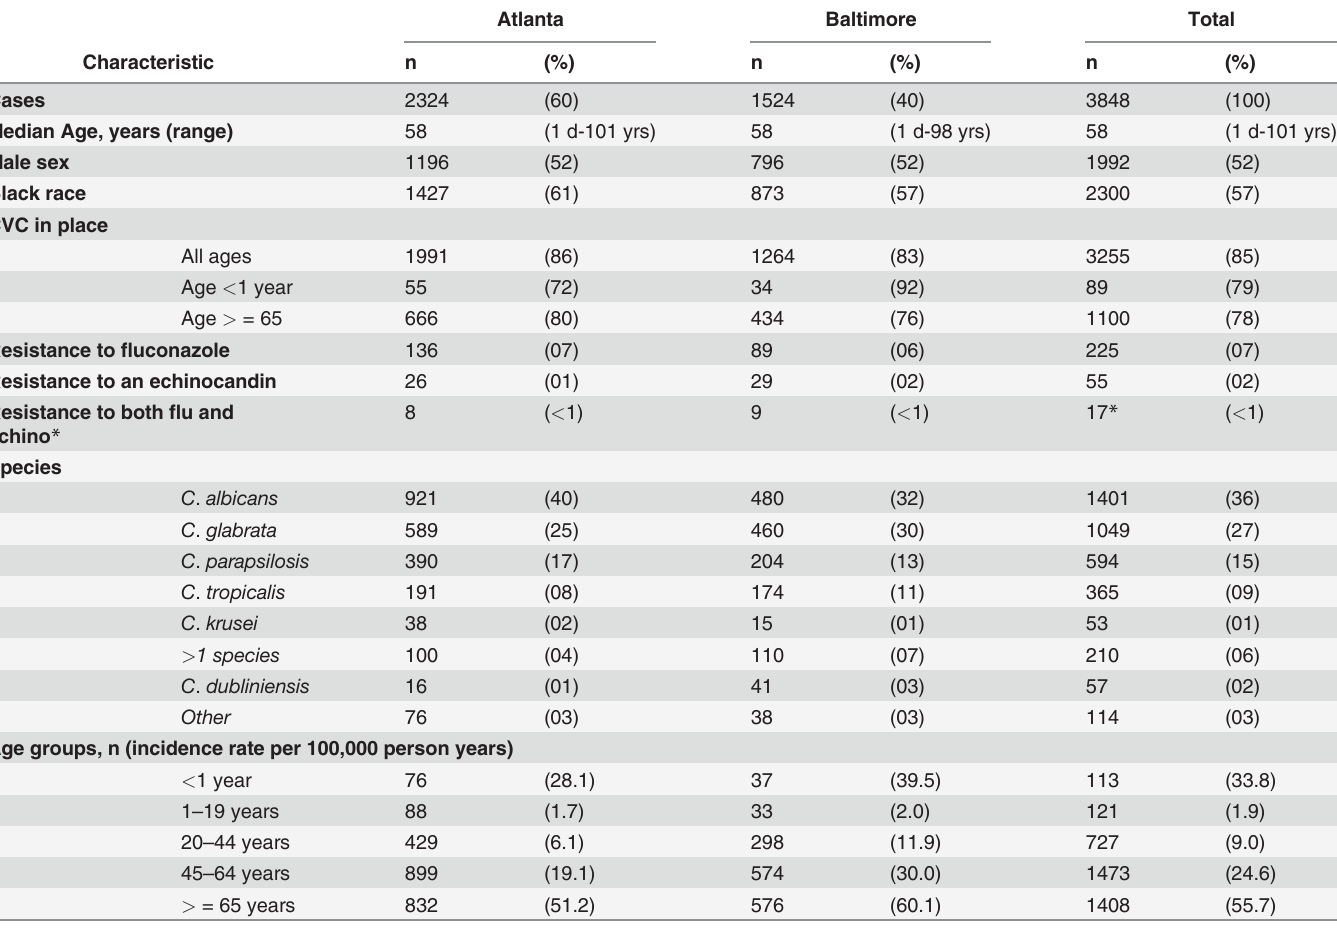
Table 1. Selected characteristics of patients with candidemia in Atlanta and Baltimore metropolitan areas.